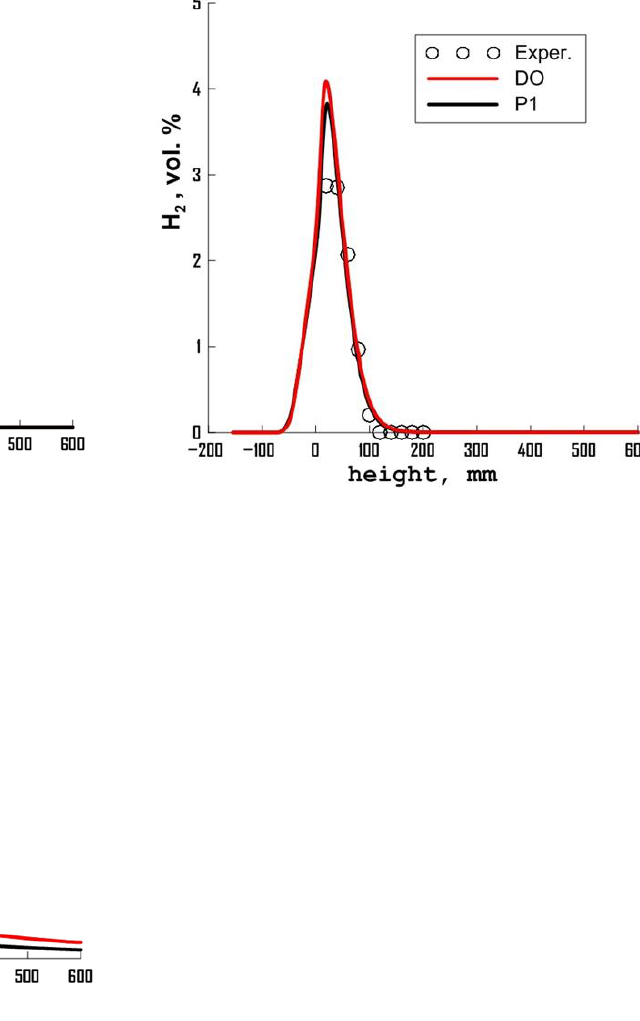
Figure 22. Distribution of temperature and gas composition along the burner axis in experiment and calculation for different radiation models.